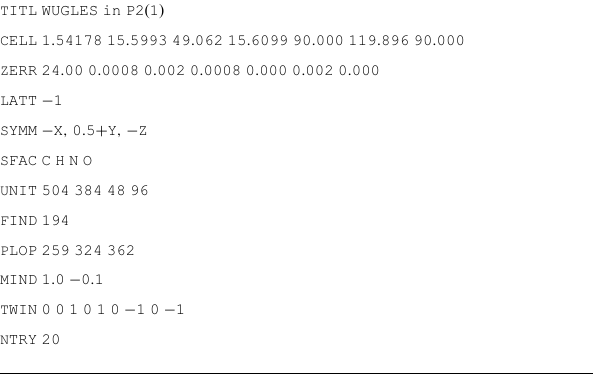
S. R. Parkin (cid:2) Practical hints and tips for solution of pseudo-merohedric twins